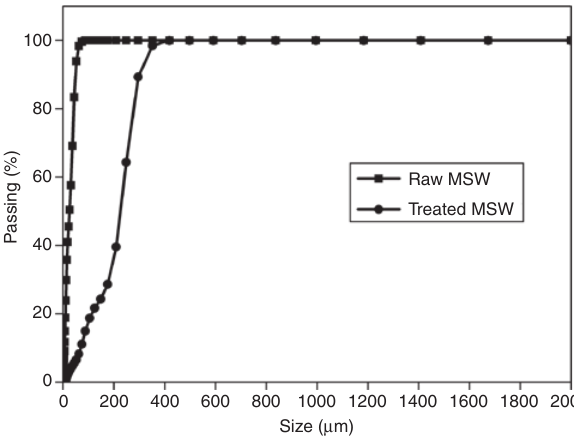
Figure 3 Particle size distribution of raw and treated MSW.